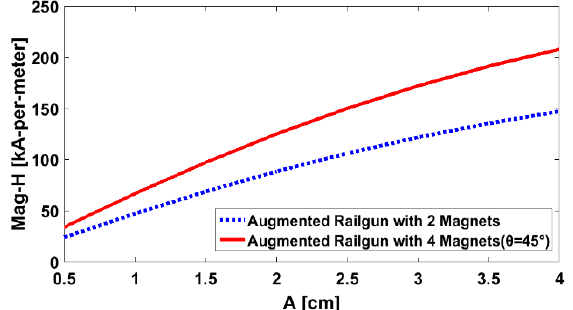
Figure 6: Magnetic field intensity versus the width (A) of permanent magnets: blue dashed line and red solid line are for the railgun structures of Figure 1 (a), (b), respectively.